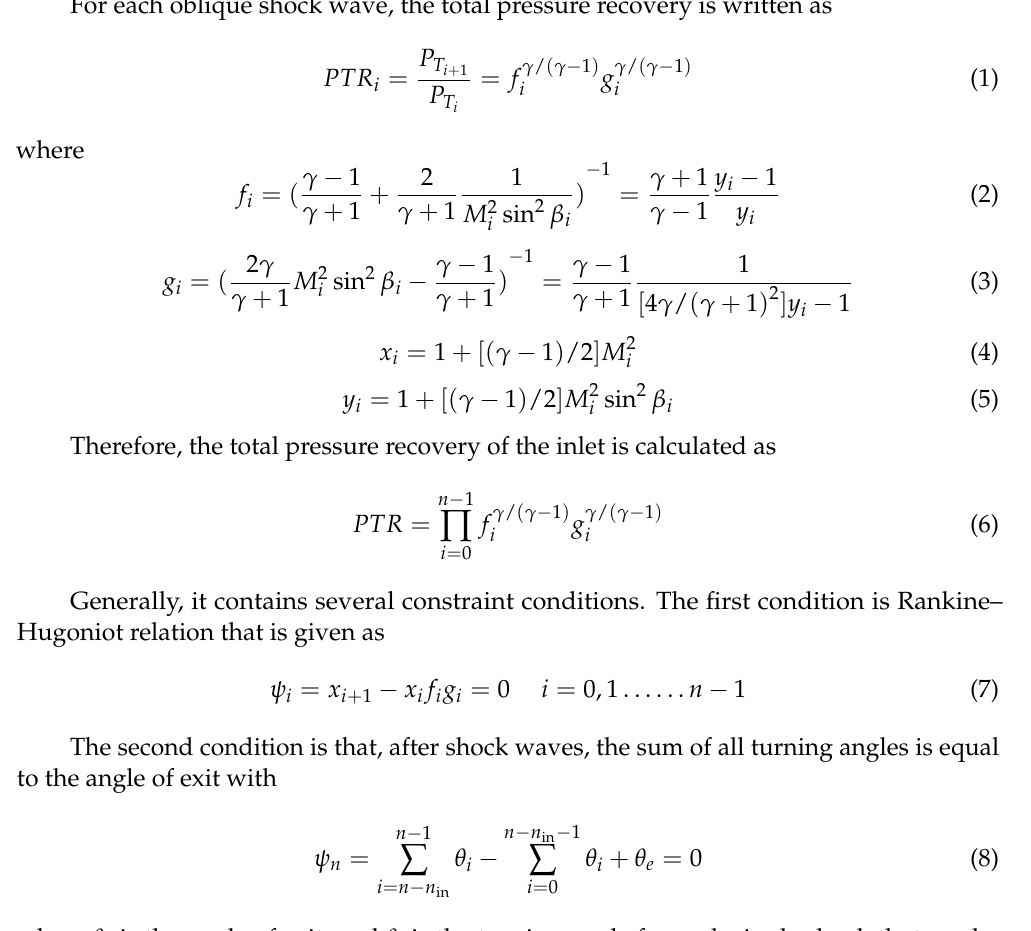
Figure 2. Schematic of the shock wave system.